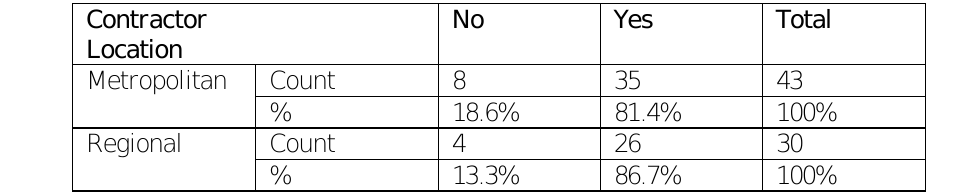
Table 8: Connections to the Internet